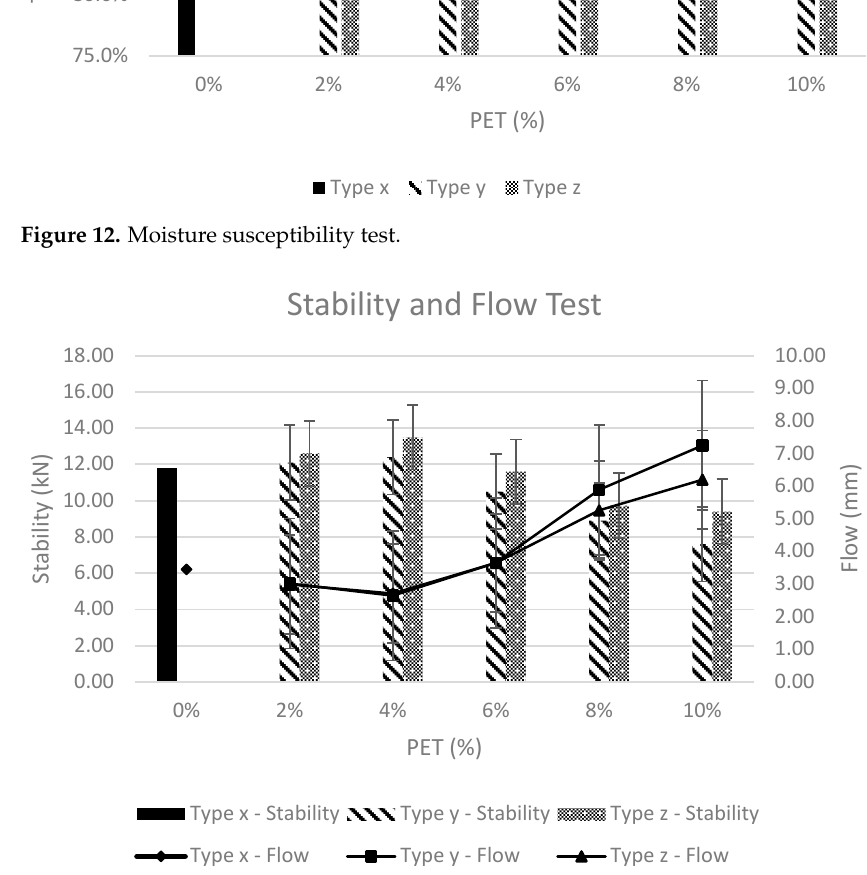
Figure 13. Stability and flow test.